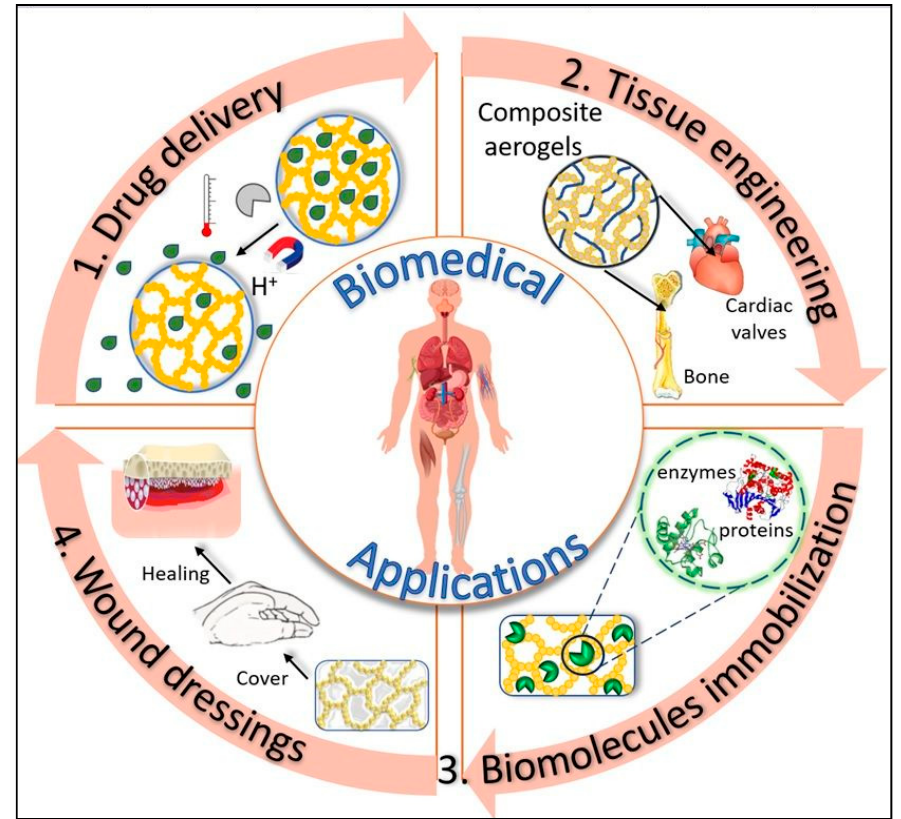
Figure 5. Applications of aerogels in the biomedical field.